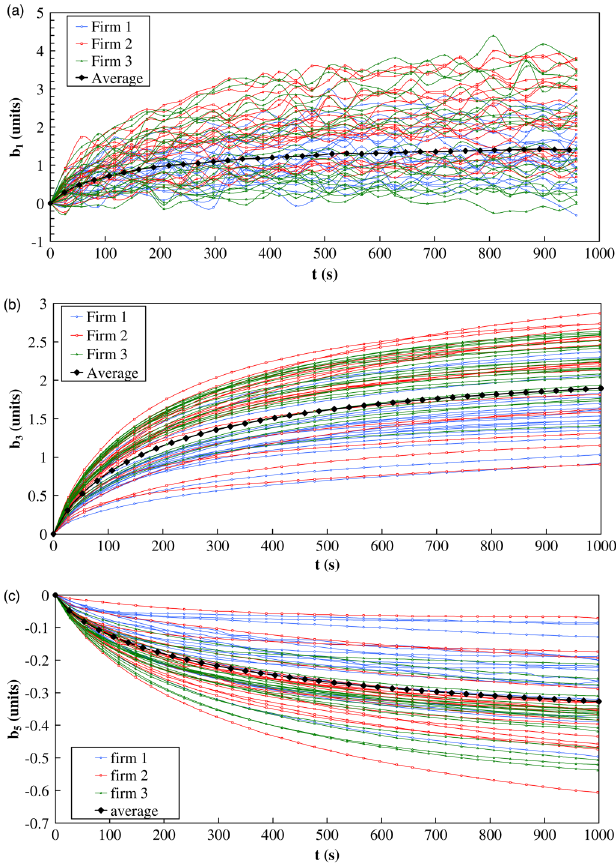
FIG. 1. (Color) (a) Decay of b 17 mm), measured during a 1000 s simulated injection plateau following a standard cleansing cycle. The values have been shifted arbitrarily along the y -axis to cancel the initial value that is magnet